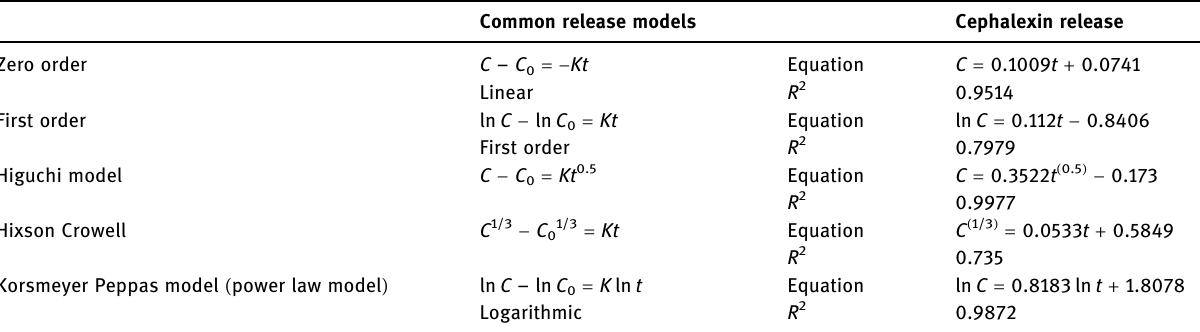
Table 4: The kinetics of cephalexin release from optimum composite hydrogels ( the R 2 and main coe ffi cients for correlated general release models )